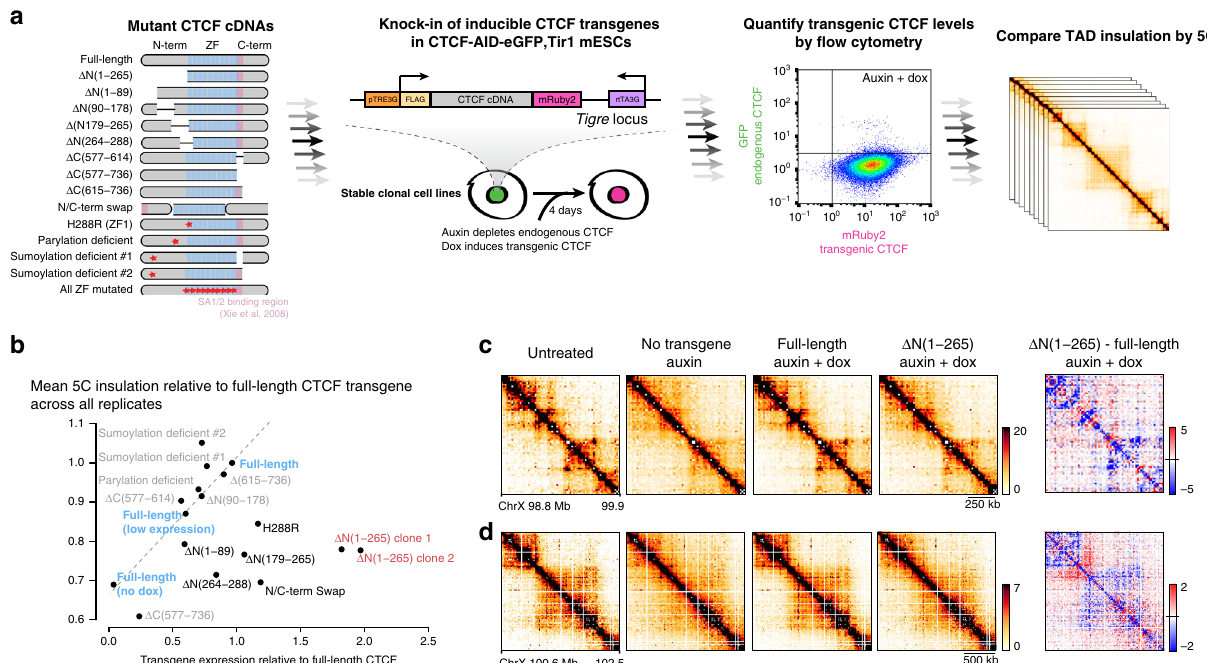
Fig. 2 Deletion scanning reveals aminoterminal domains of CTCF that mediate TAD folding. a Experimental pipeline for the mutational analysis of CTCF using stable transgenic mESCs. Red stars indicate amino-acid substitutions as detailed in the “ Methods ” . Flow cytometry con fi rming homogeneous induction of the transgenes (only full length is shown). Gates were placed using untagged cells. b Summary of 44 5C experiments across 16 stable mESC lines treated with dox and auxin. Each data point is the mean of the insulation scores at the six TAD boundaries initially detected in WT-untreated samples, averaged across at least two 5C replicates, and presented as ratios relative to insulation measured in the full-length CTCF transgene. Transgene-expression values correspond to fl ow-cytometry means across at least two replicates. The dashed line shows the linear regression for the dependence of insulation on transgene expression, and was obtained by comparing cell lines with high, low, or no full-length transgene expression for full-length CTCF. Transgenes with all zinc fi ngers (ZFs) mutated were poorly expressed and not assessed by 5C. c , d Snapshots of 5C data binned at 15 kb, and the corresponding